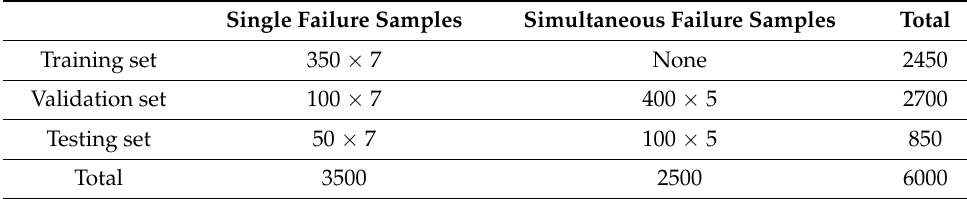
Table 2. Assignment of the experimental